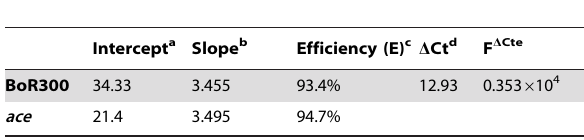
Table 2. Comparative analysis data of the qPCR amplification curves of BoR300 repeats and the single copy gene ( ace ), for the absolute estimation of BoR300